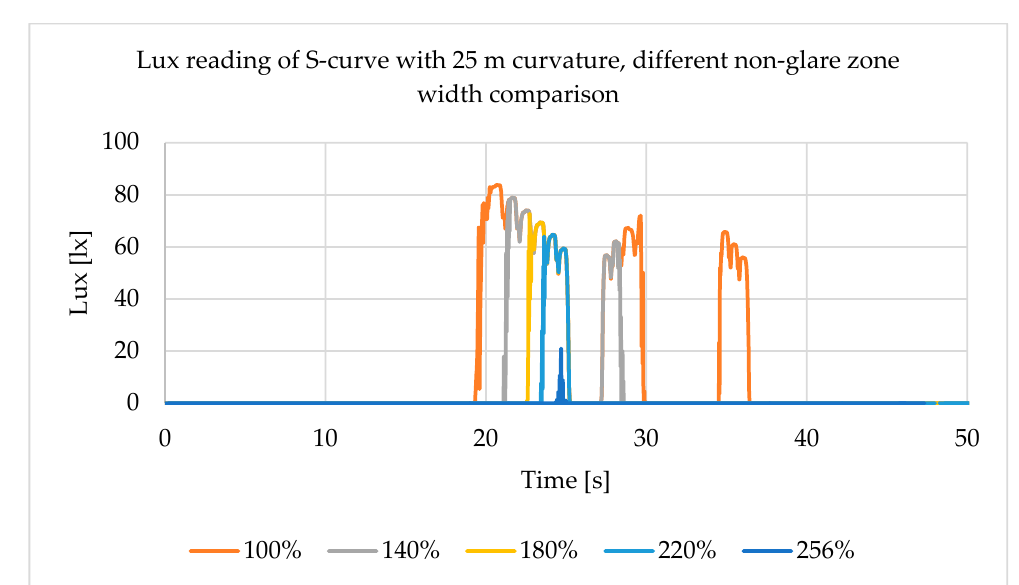
Figure 9. S-curve with 25 m curvature simulation at 100% non-glare zone width: ( a ) At the beginning of the simulation, the vehicle travels on a straight road, and no glare is created. ( b ) When the vehicle enters the corner, glare is created, corresponding to the first peak in Figure 8. ( c ) When the stimulus vehicle exits the high beam area, there is a short time when glare drops to zero, corresponding to the area between two peaks in Figure 8. ( d ) Light penetrates through the vehicle body due to the limitation of the simulator, which is shown as the third peak in Figure 8 and is neglected as an error.